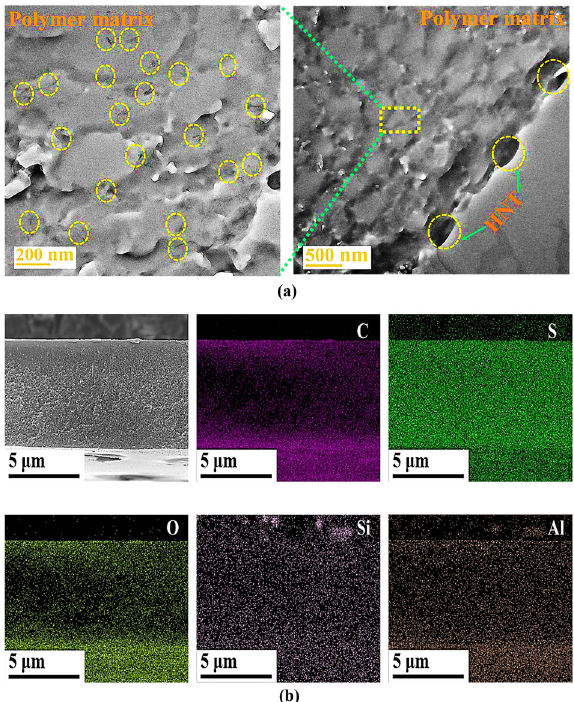
Fig. 5 HNTs distribution characterization. TEM micrographs showing distribution of HNTs in M6 ( a ) TEM micrographs ( b ) EDX mapping image of the PSF/EVOH/HNTs